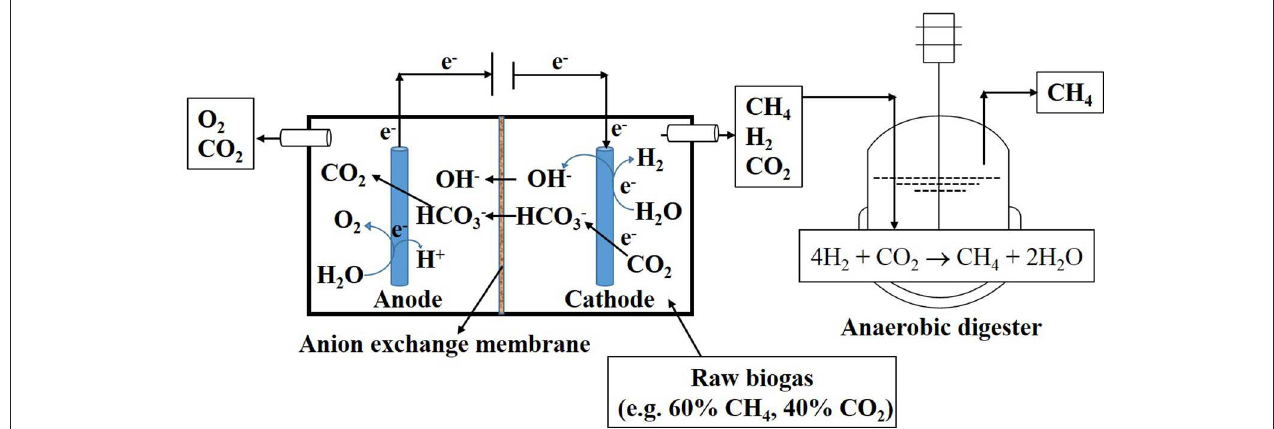
FIGURE 2 | Schematic reactor setup for microbial electrochemical and membrane electrolysis-assisted in situ biogas upgrading. Modified based on Verbeeck et al. (2019) with permission/license granted by the